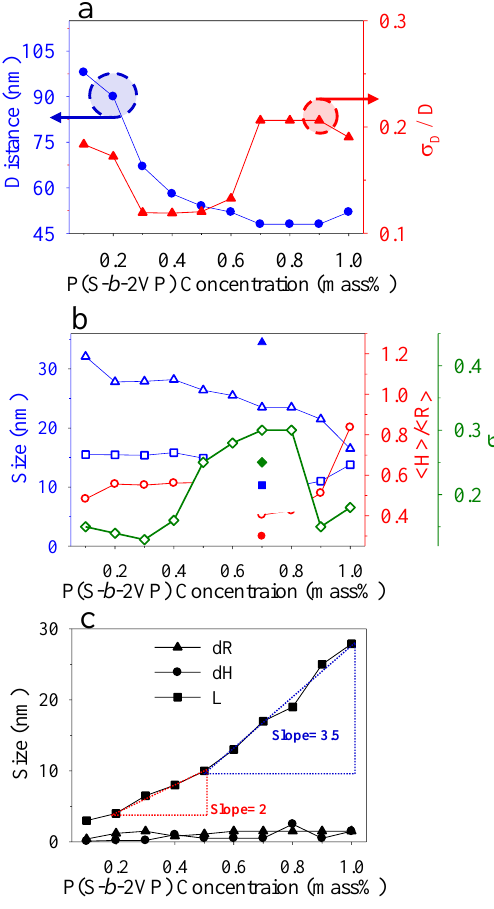
Figure 4. ( a ) Spatial order parameters, the nearest-neighbor distance ( D : filled circles) and disorder parameter ( σ D / D : filled triangles), are plotted as a function of concentrations; ( b ) Extracted heights (< H >: open squares), radius (< R >: open triangles), size distribution ( σ R : open diamonds), ratio of heights to radius (< H >/< R >: open circles), of the core shape are plotted as a function of concentrations. Solid symbols with a superscript e indicates the structural parameters for hemi-spheroid cores; the ratio of major to minor radius used for the modeling is 1.5–5 with a Gaussian distribution ( c ) The thickness of PS shells ( dR: filled triangles; dH : filled circles) and thickness of the homogeneous layer at the substrate interface ( L : filled squares). The dash-lined triangles indicate slopes (nm per wt %) at each stage.